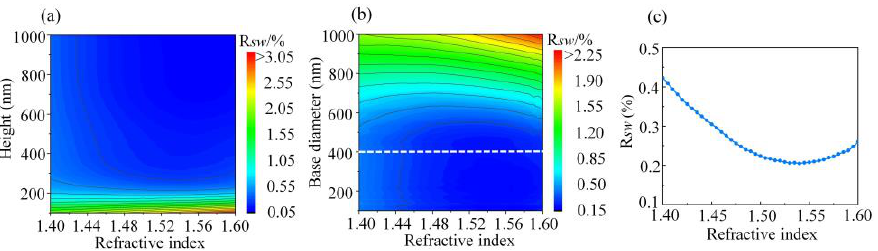
Figure 6. Contour plots of solar-weighted reflectance of PSMS/PET at different polymer refractive indices when ( a ) base diameter is fixed at 400 nm and ( b ) height is fixed at 300 nm. ( c ) The curve of solar-weighted reflectance changing with different polymer refractive indices when D = 400 nm and H = 300 nm.